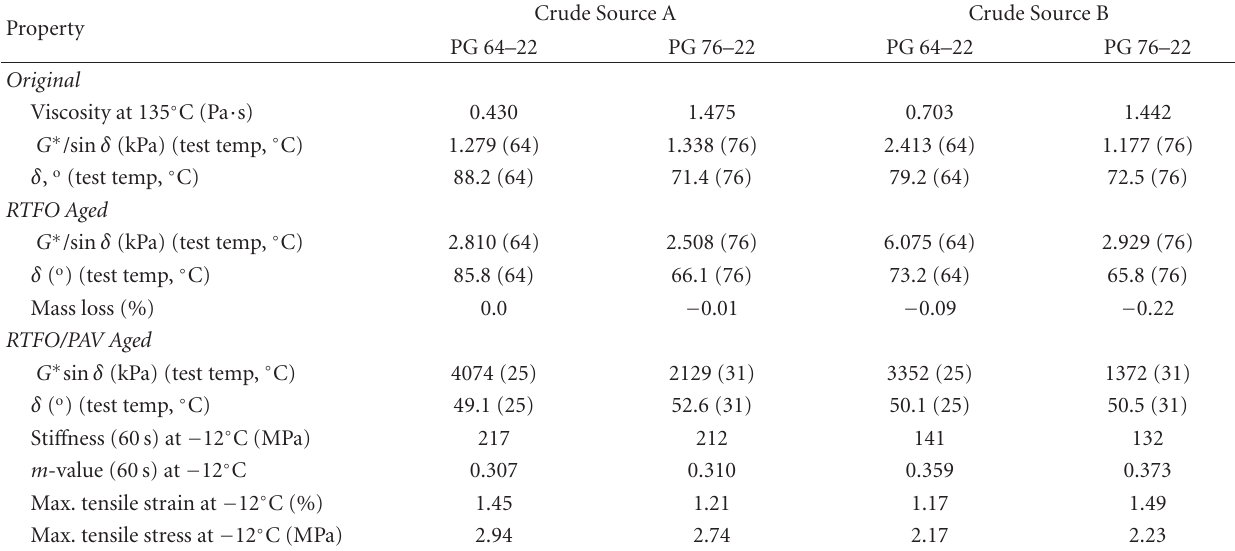
Table 2: Properties of asphalt